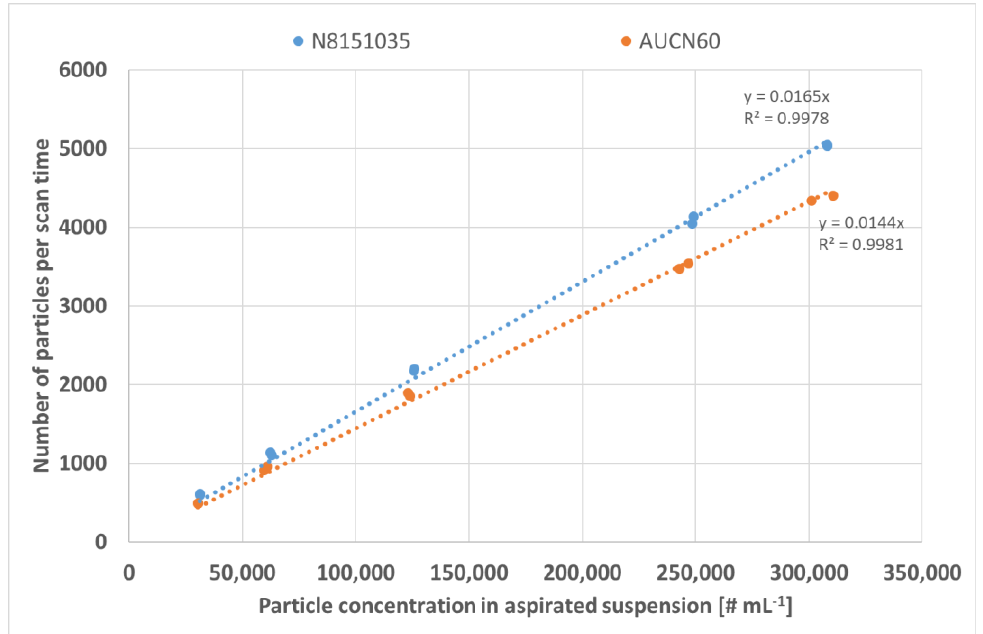
Figure 14. Relation between the theoretical calculated number of particles in the analysed suspensions and the detected number of particles per scan time.